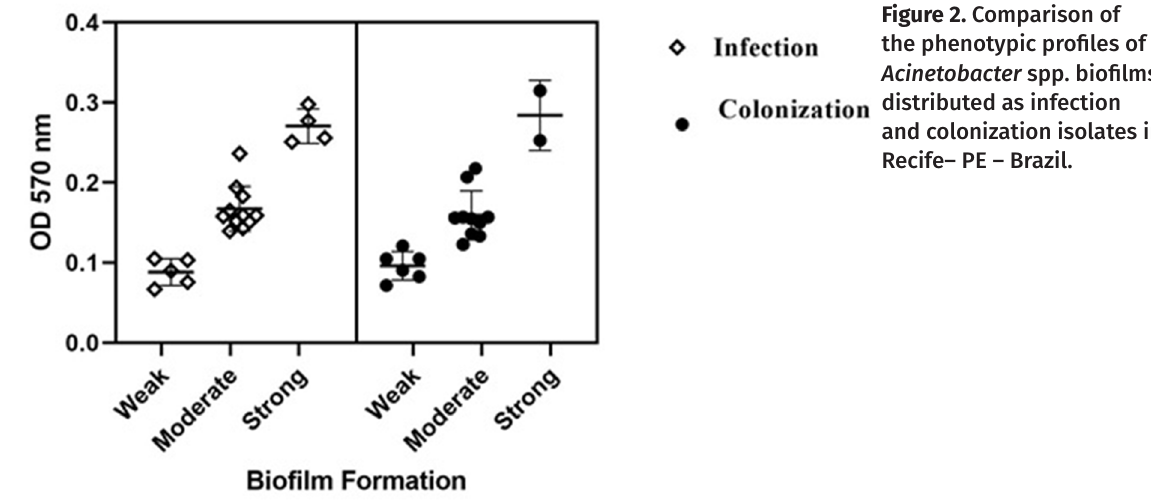
Figure 2. Comparison